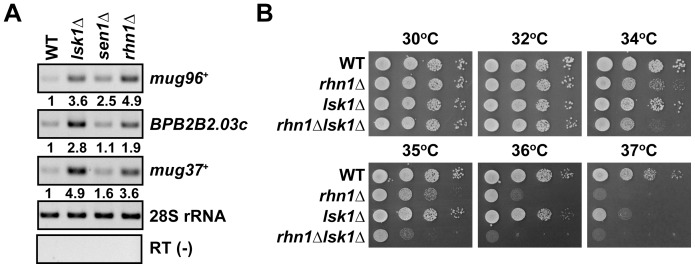
Rhn1, Lsk1, and Sen1 contribute to the suppression of meiotic mRNAs in vegetative cells.(A) The effect of an lsk1 or sen1 deletion on meiotic mRNA levels in vegetative cells. Total RNA isolated from wild-type (WT), lsk1Δ, sen1Δ, or rhn1Δ cells was subjected to RT-PCR analyses. The 28S rRNA was used as an internal control. The fold increases relative to wild-type cells are shown below each lane. RT (-), no reverse transcription. (B) Synthetic growth defect of rhn1Δlsk1Δ cells. Serial dilutions of wild-type (WT), rhn1Δ, lsk1Δ, or rhn1Δlsk1Δ cells were spotted onto YEA plates, and the plates were then incubated at the indicated temperatures for 3 to 4 days.